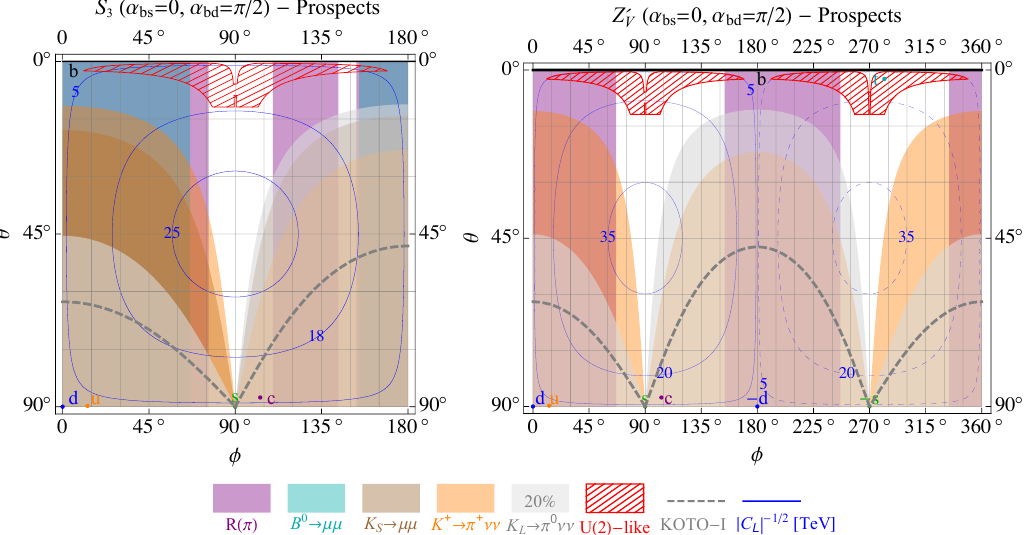
Figure 7 . Future prospects for the exclusion limits in the ( (cid:30); (cid:18) ) plane for the scalar leptoquark S 3 (left) and the vector singlet Z 0 with vector-like couplings to muons (right), for a choice of phases. The orange and gray regions correspond to the future expected limits from K + ! (cid:25) + (cid:23)(cid:23) (NA62 [83]) and K L ! (cid:25) 0 (cid:23)(cid:23) (KLEVER [82] or KOTO phase-II), respectively. The dashed gray line corresponds to the expected limit on K L ! (cid:25) 0 (cid:23)(cid:23) from KOTO